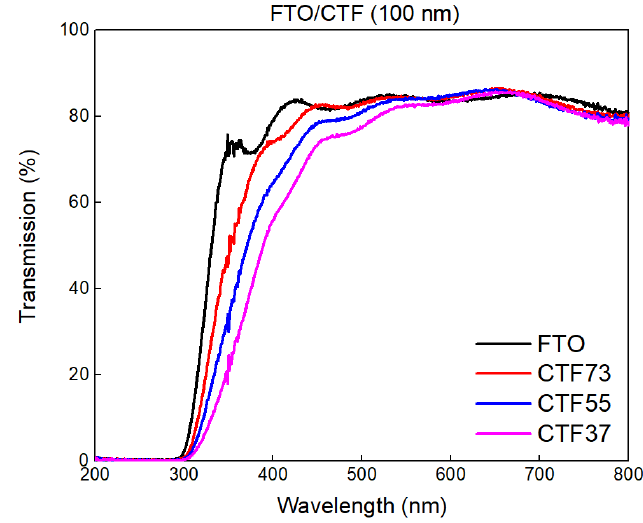
Figure 7. Optical properties of CaTi 0.7 Fe 0.3 O 3−δ (CTF73), CaTi 0.5 Fe 0.5 O 3−δ (CTF55), and CaTi 0.3 Fe 0.7 O 3−δ (CTF37), perovskite films developed by pulsed laser deposition on FTO.